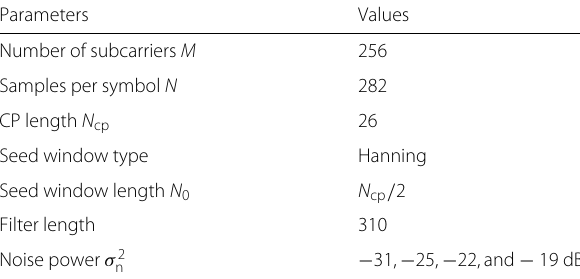
Table 4 Parameters for bi-orthogonal based transmit pulse